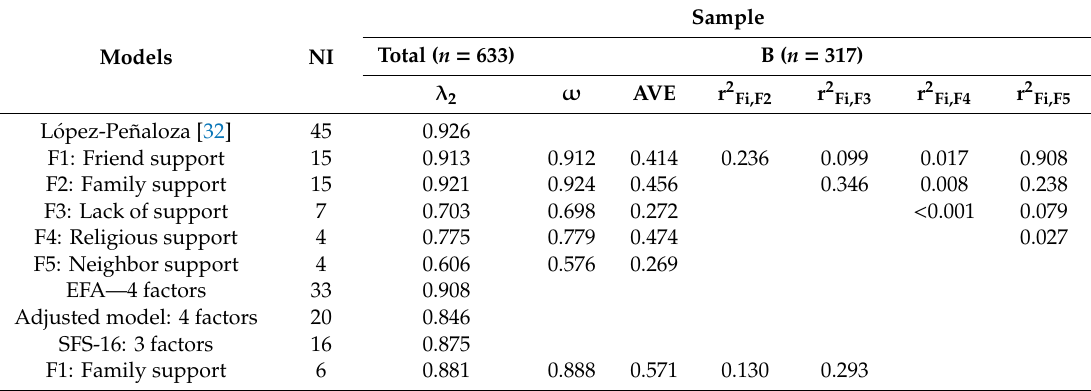
Table 3. Reliability, convergent validity, and discriminant